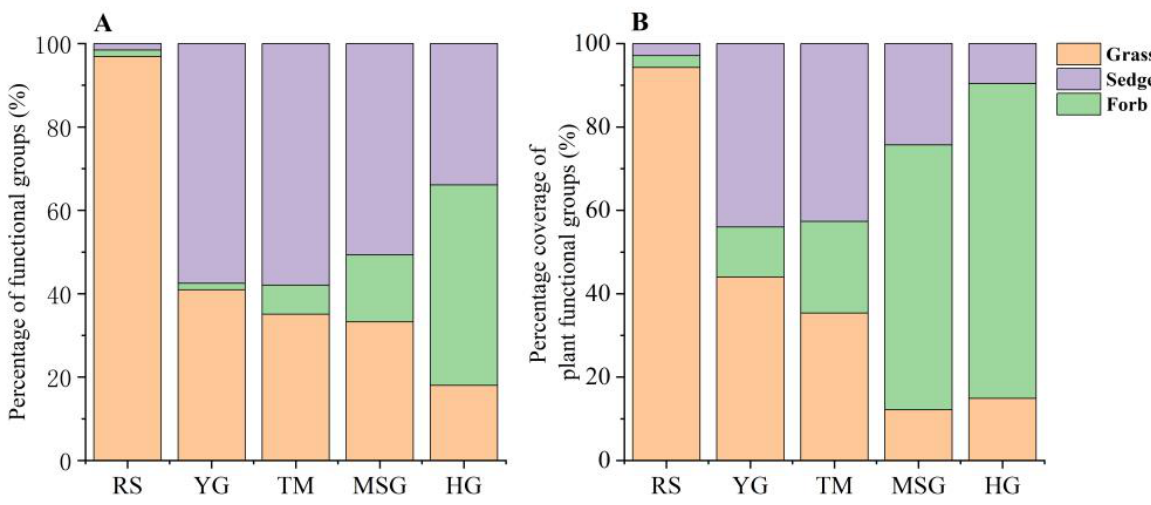
Figure 4. Percentage of functional groups ( A ) and percentage of coverage of three plant functional groups ( B ) under different land uses.